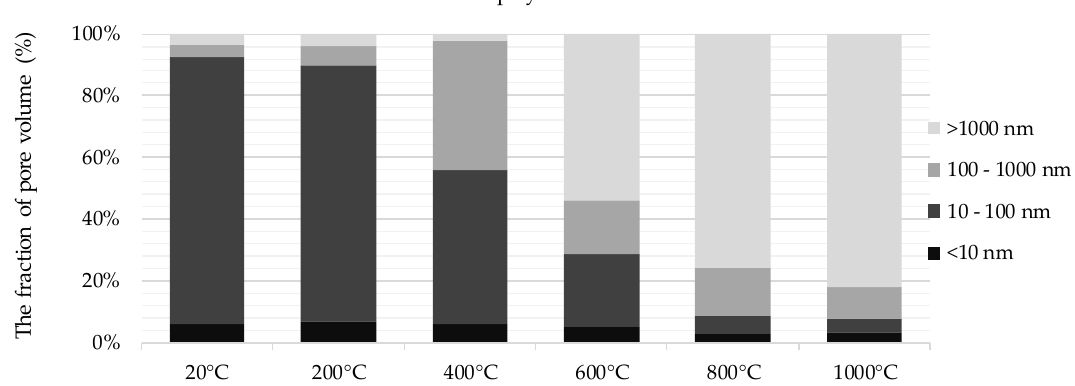
Figure 4. Categorization of pores for mortars based solely on FA (M0), depending on the temperature applied to the material.